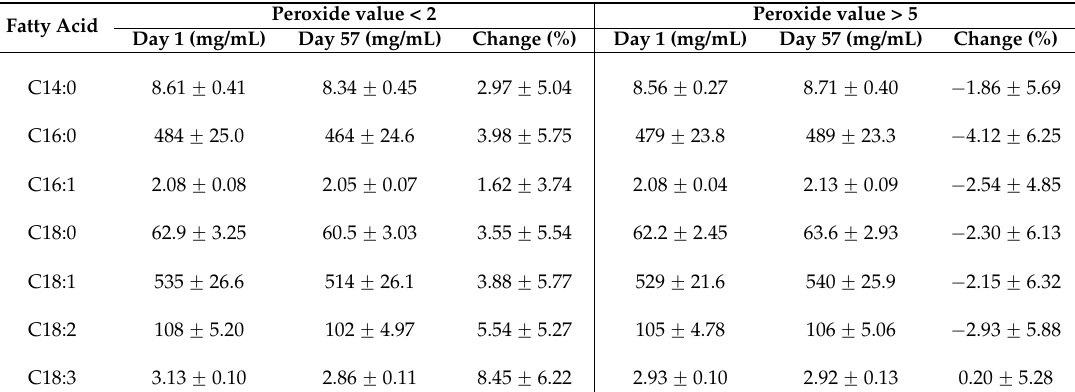
Table 2. Fatty acid composition in non-fortified palm oil with different initial oxidation